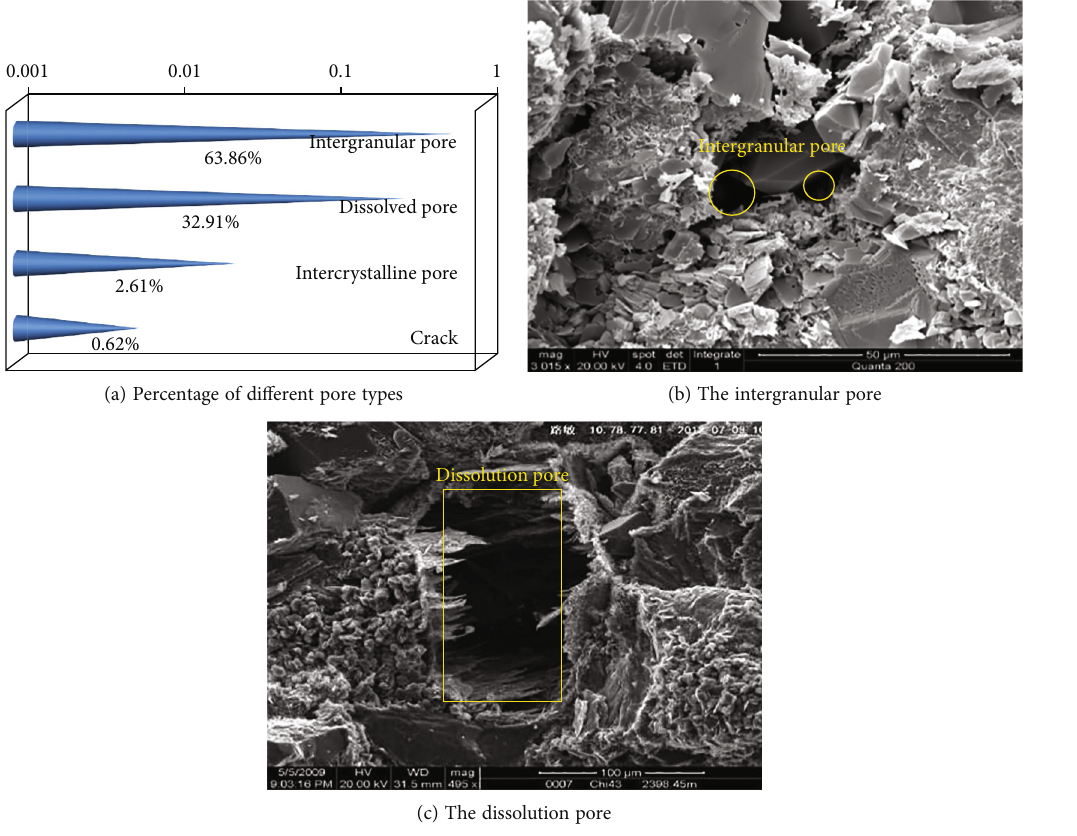
Figure 2: The distribution diagram of pore